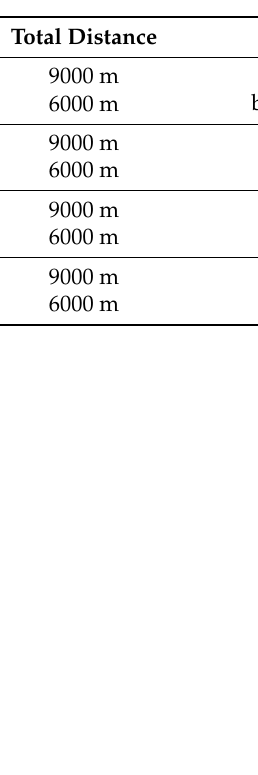
Table 4. Average results from the variation of final